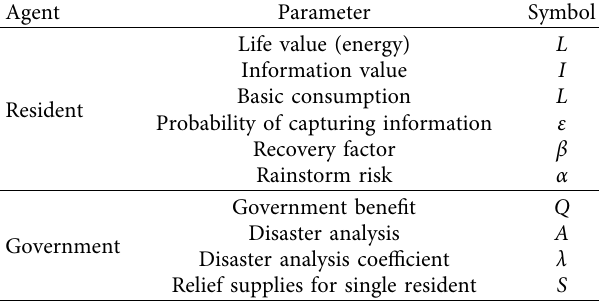
Table 1: Parameters of resident and government.